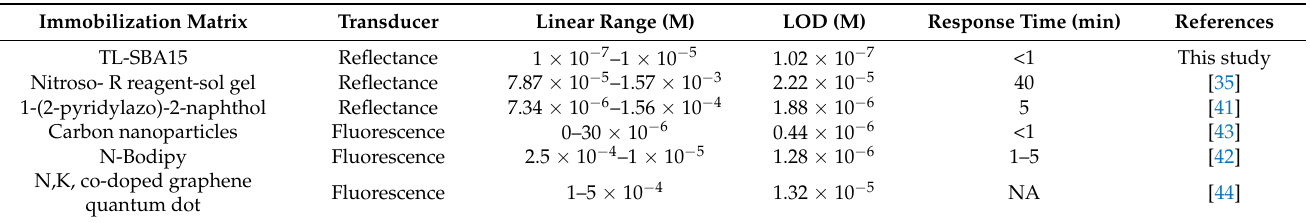
Table 3. Analytical performance comparison between the constructed optical sensor and several reported optical sensors for Cu 2+ ion